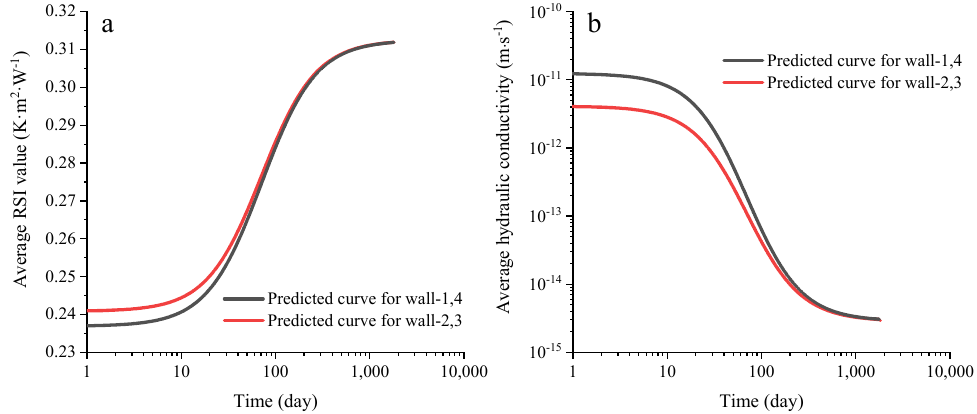
Predicted curve for wall-1,4 Predicted curve for wall-2,3 Figure 11. Predicted ( a ) average RSI and ( b ) hydraulic conductivity of the RE walls from El Nabouch [28].